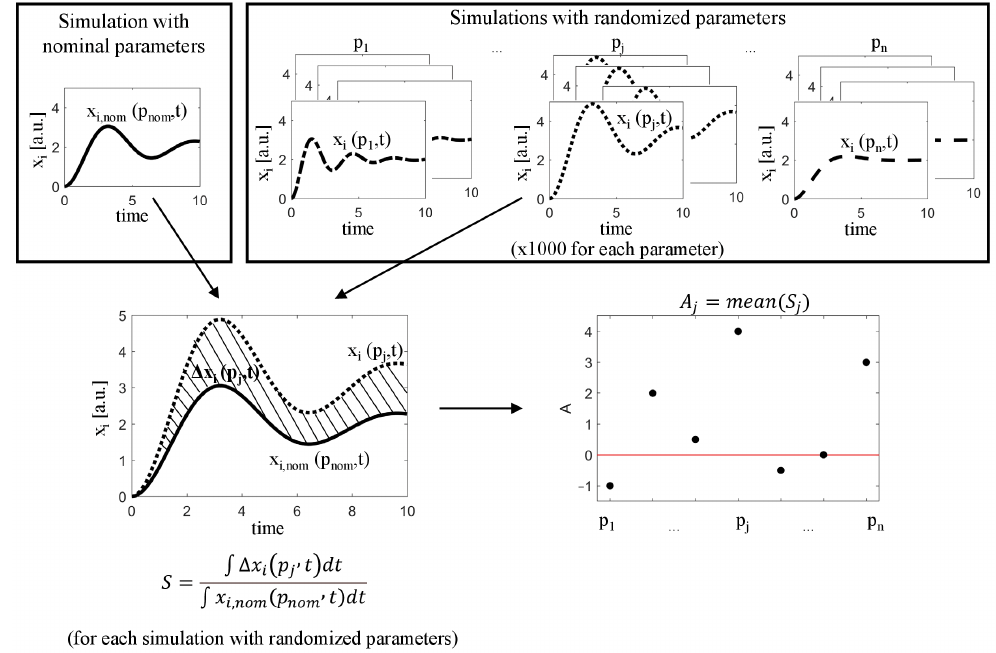
Figure 11. A simplified diagram showing the idea behind the algorithms used for sensitivity analysis. As mentioned in the preceding section, we concentrate on inhibitory drug actions. For example, when binding to their respective targets, a drug may block the active site that becomes unavailable for other molecules, and thus, makes the target unavailable for a given process. By blocking the active sites of selected molecules, it is also possible to indirectly stimulate the process, e.g., through blocking the inhibitor of that process [7]. The method shown in the paper is general enough also in the case when stimulation is straightforward, as is in the case of recombinant proteins [53]. The only difference from the case studies shown in the Results section would be in the distribution used for sampling α values that should be the amplification